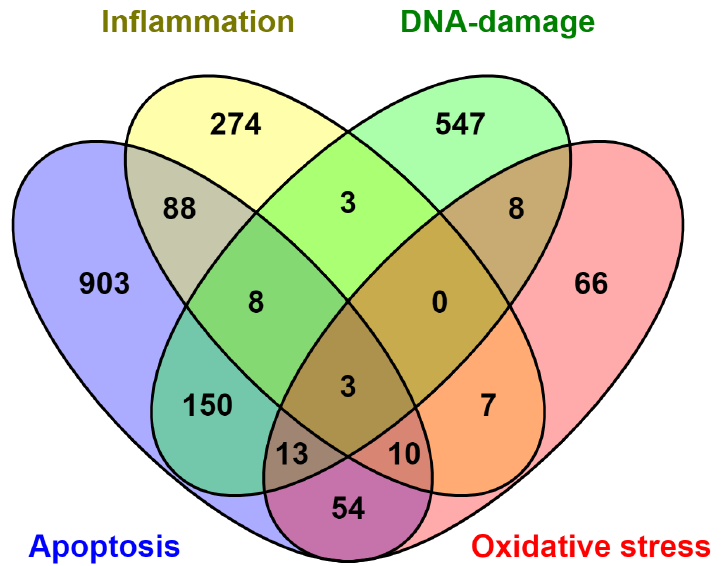
Figure A1. Venn diagram showing the number of overlapping genes between the four GO-terms “apoptotic process”, “inflammation”, “cellular response to DNA damage stimulus”, “DNA damage and Oxidative stress”.